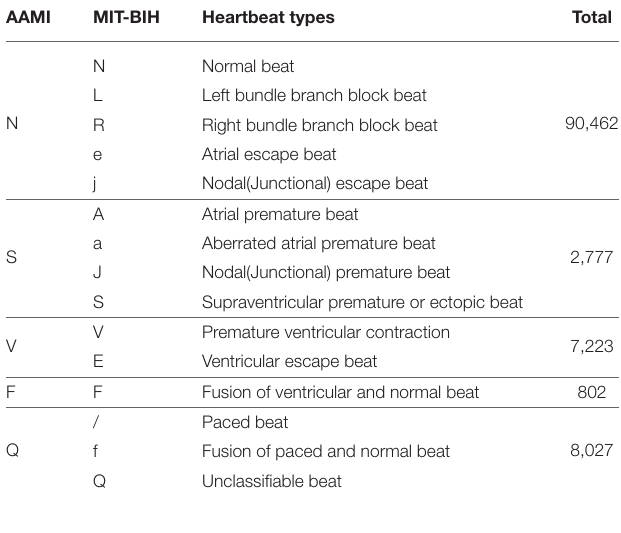
TABLE 4 | Mapping the heartbeat types to the AAMI heartbeat categories and data distribution statistics (Moody and Mark, 2001).